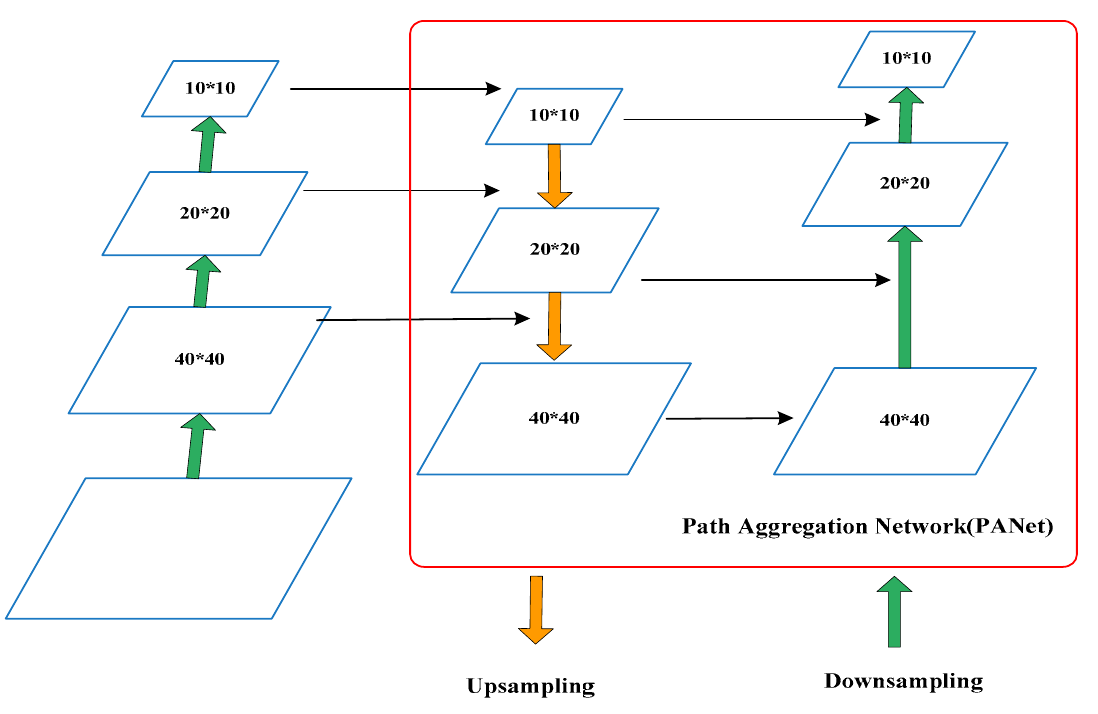
Figure 2. PANet structure.